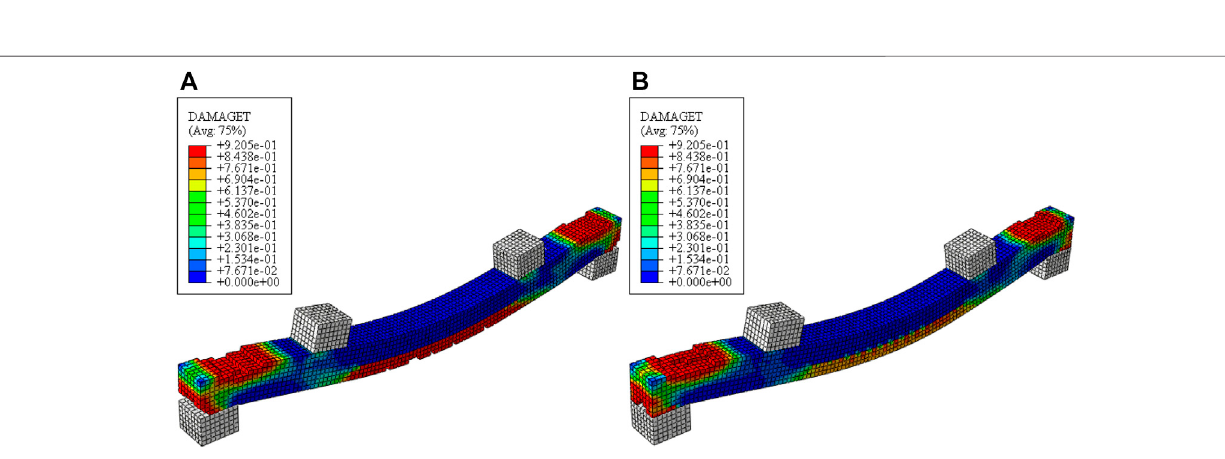
FIGURE 15 | Concrete beams under load damage: (A) ordinary reinforced concrete beams; (B) CFRP wrapped concrete reinforced beams.